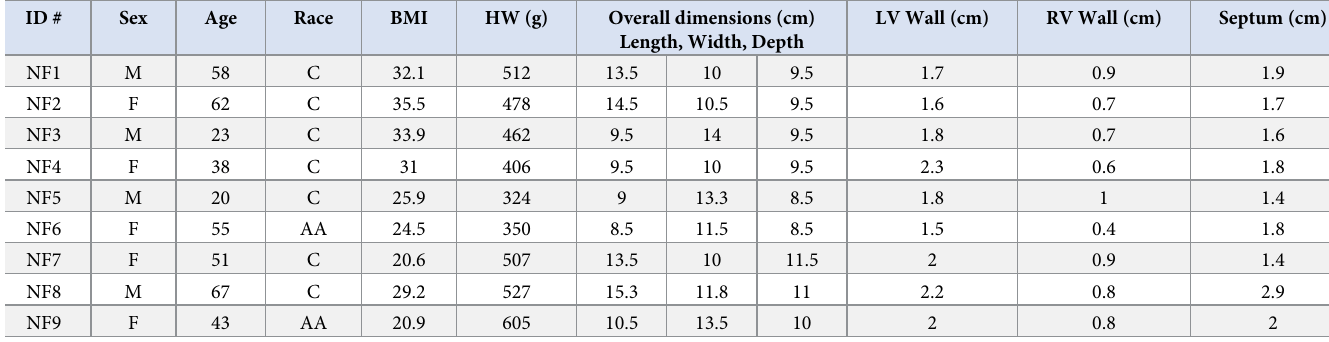
Table 1. Donor demographic and characteristics of procured human hearts (NF; n = 9).